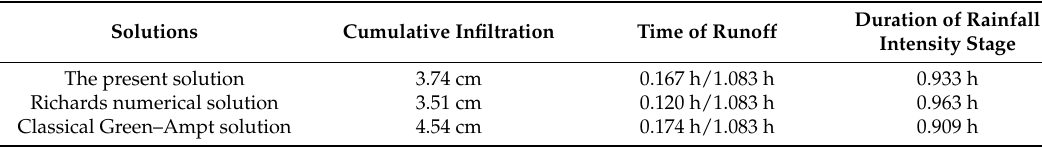
Table 2. Comparison of calculation results under unsteady rainfall intensity.